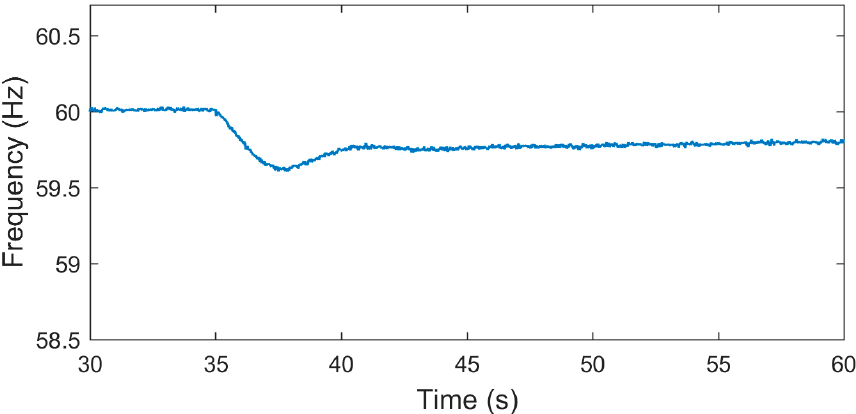
Figure 16. Grid frequency (wind farm).